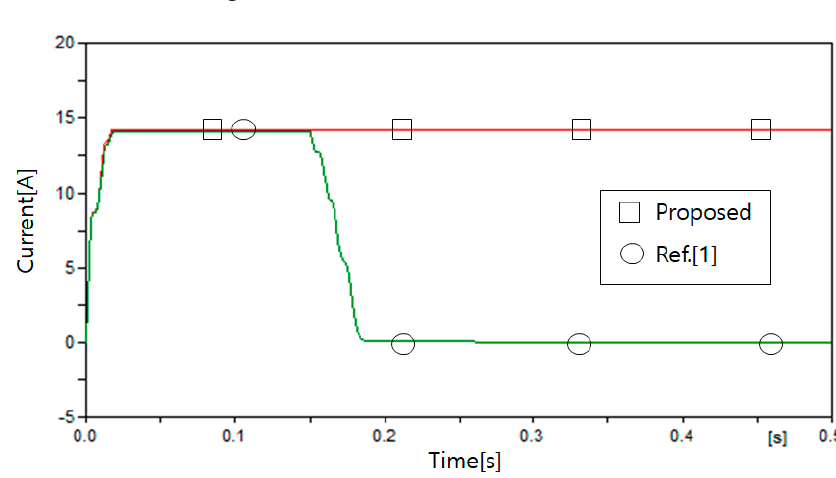
Energies 2020 , 13 , x FOR PEER REVIEW Figure 14. Current measured at I 1 in Case 3. Figure 14. Current measured at I 1 in Case 3.